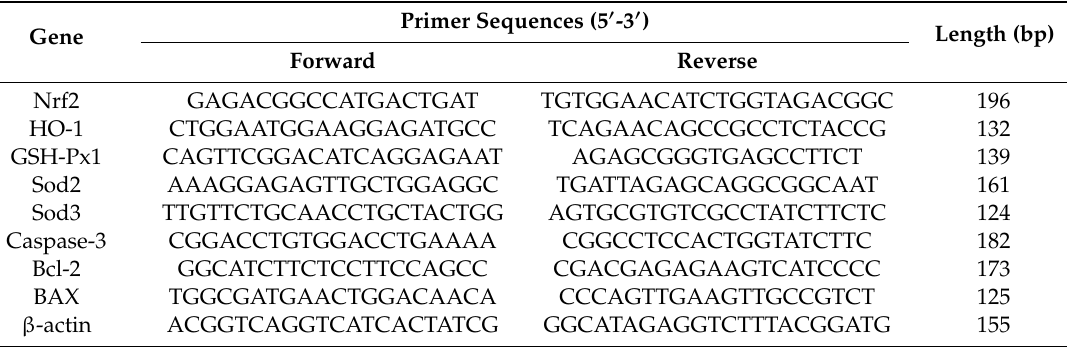
Table 1. Primer sequences used in real-time